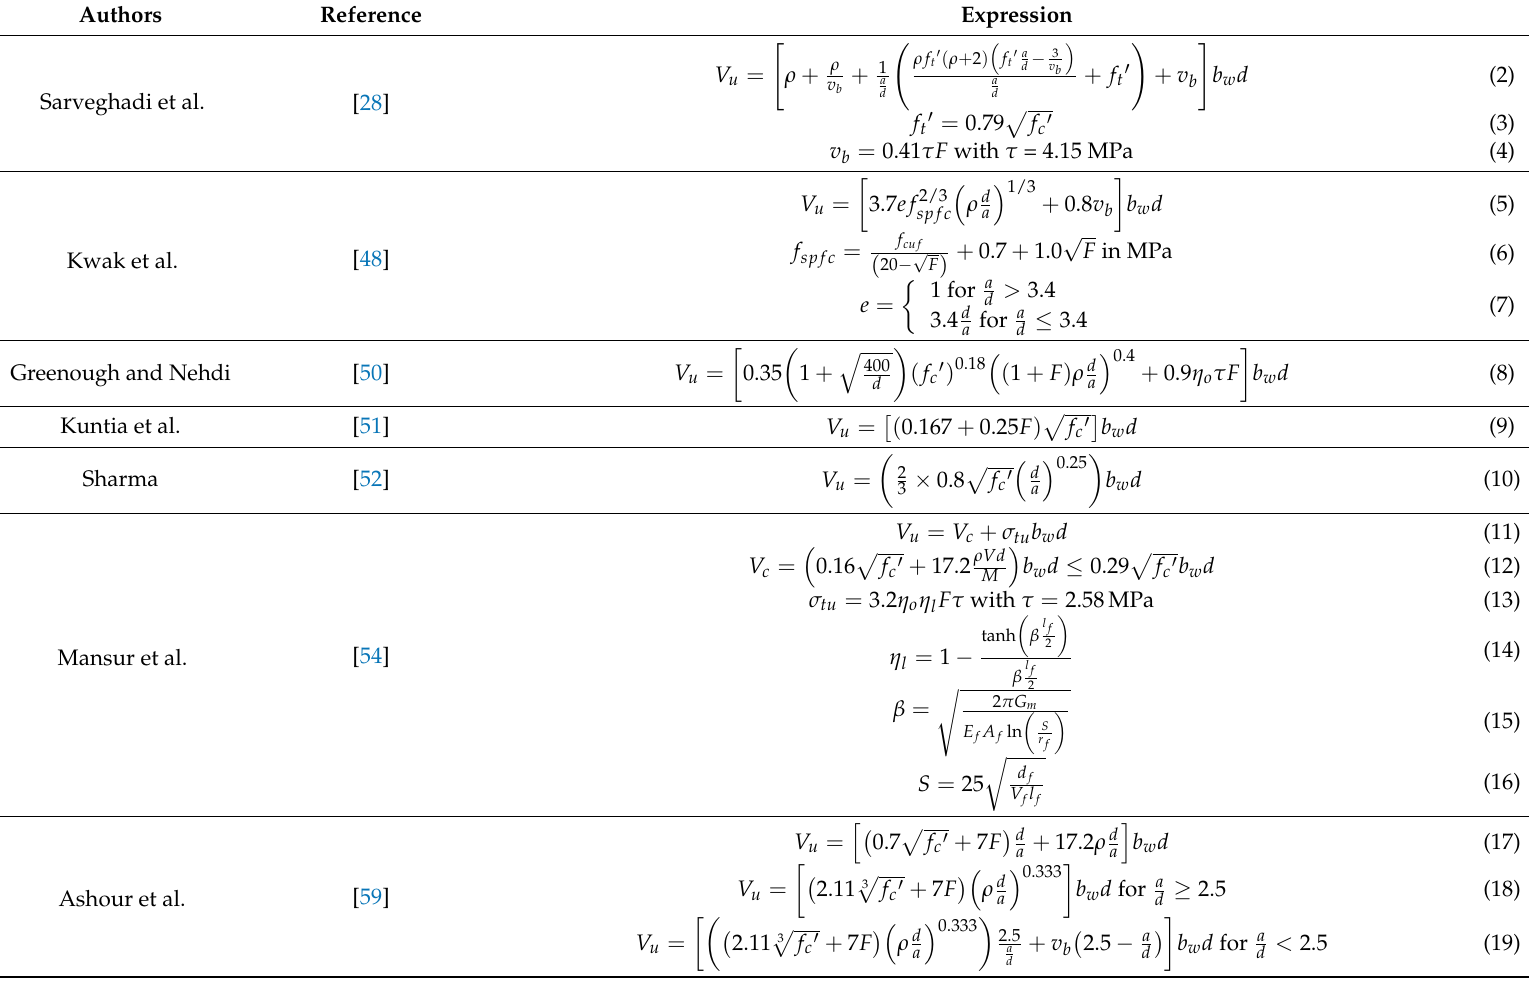
Table 1. Shear prediction equations from literature and available